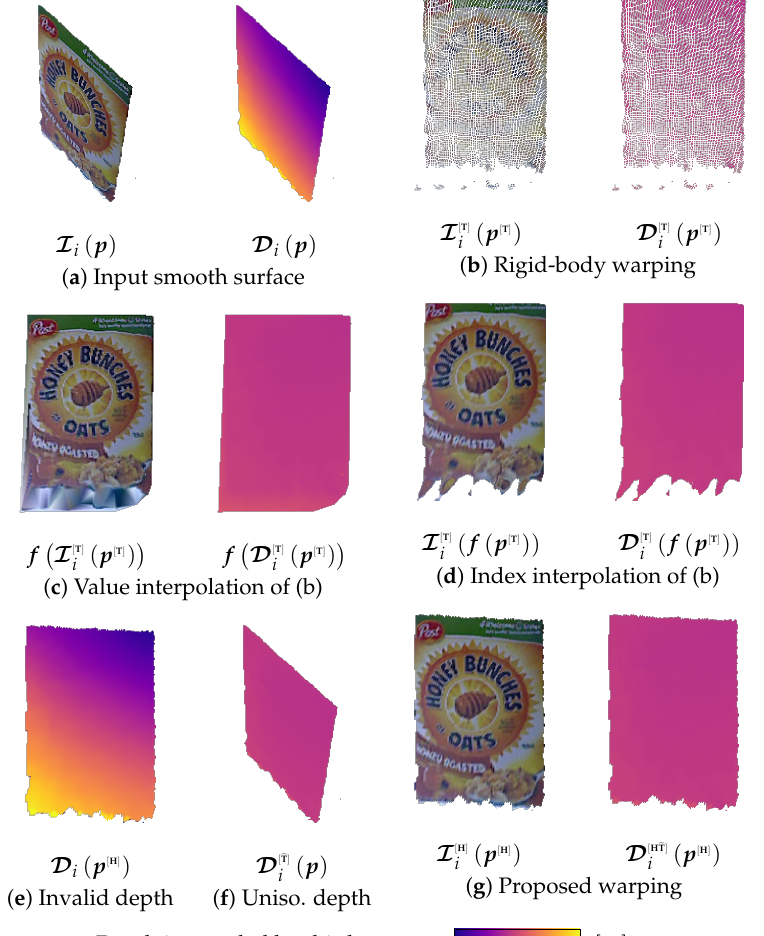
Figure 4. RGB-D warping techniques and the proposed improvement. ( a ) a smooth-surface ) tuple, ( , , that is not parallel to the virtual image plane, which can be ( b ) rigidly warped parallel i I D to the virtual image plane; however, this produces many missing-value pixels, as well as some outliers (Section 2.4.1). Common approaches to fill the missing pixels include ( c ) value interpolation ) denotes the interpolation operator. Although interpolation or ( d ) index interpolation, where f ( · can fill intra-point spaces, it also extrapolates spaces between the smooth surface and the boundary outliers, thereby creating artifacts. However, because the warped points represent a smooth surface, homography is investigated; ( e ) planar homography results in invalid depth warping. Therefore, a hybrid method is proposed, in which ( f ) an unisomorphic rigid warping to the depth map is computed, followed by a homography transformation; resulting in ( g ) the proposed hybrid rigid-homography warping (Section